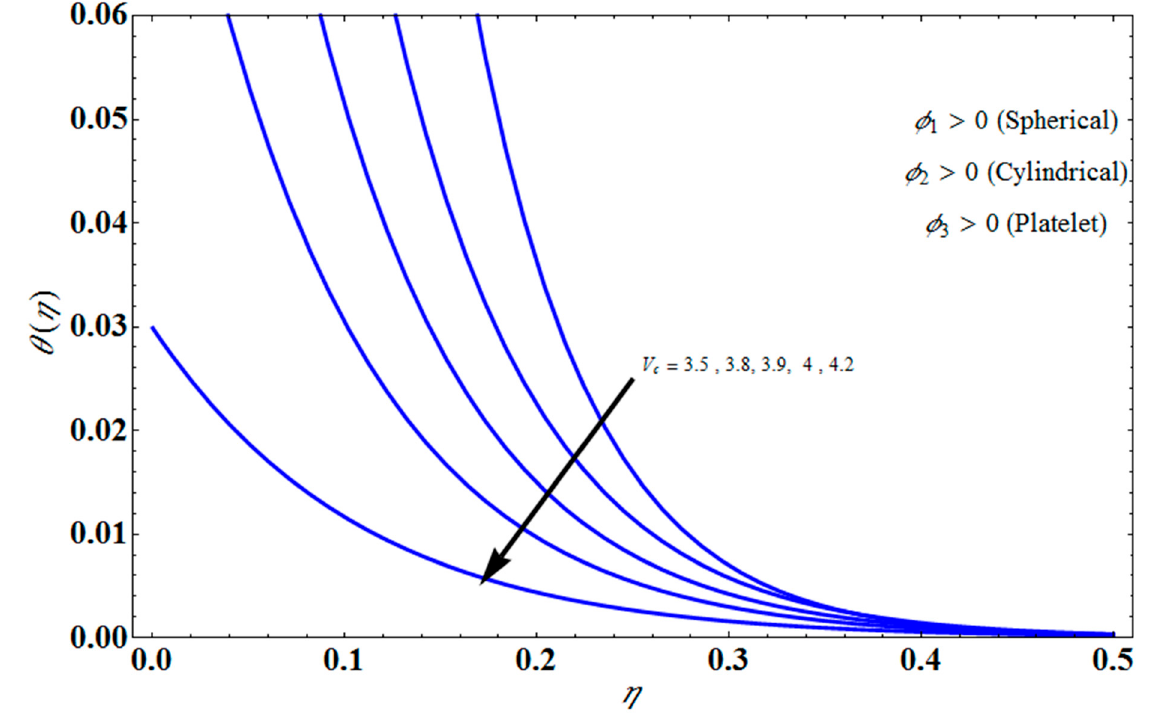
( ) θ η η ( ) θ η η on for different values of on for different values of